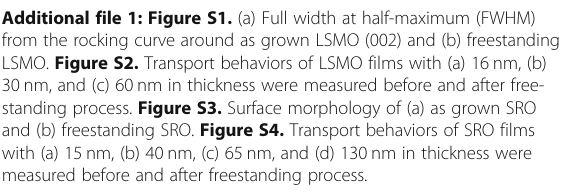
Supplementary information Supplementary information accompanies this paper at https://doi.org/10. 1186/s11671-020-03402-0. Additional file 1: Figure S1. (a) Full width at half-maximum (FWHM) from the rocking curve around as grown LSMO (002) and (b) freestanding LSMO. Figure S2. Transport behaviors of LSMO films with (a) 16nm, (b) 30nm, and (c) 60nm in thickness were measured before and after free- standing process. Figure S3. Surface morphology of (a) as grown SRO and (b) freestanding SRO. Figure S4. Transport behaviors of SRO films with (a) 15nm, (b) 40nm, (c) 65nm, and (d) 130 nm in thickness were measured before and after freestanding process.